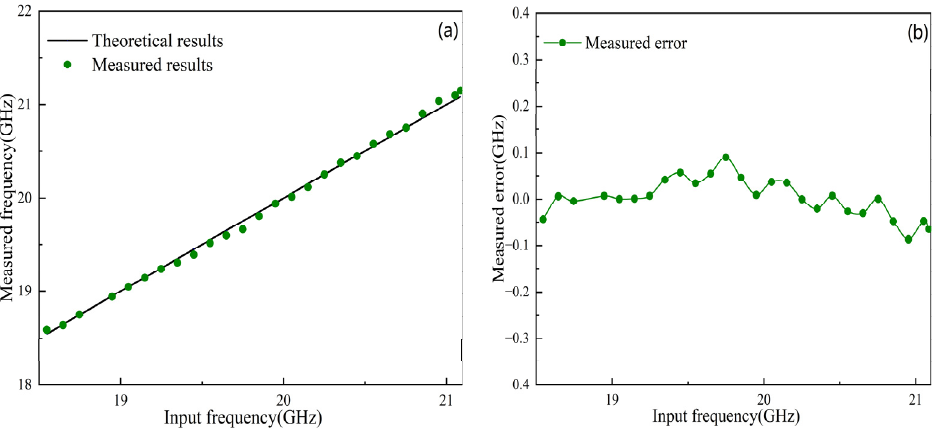
Figure 6. ( a ) Theoretical and measured results of frequency measurements. ( b ) measurement error.